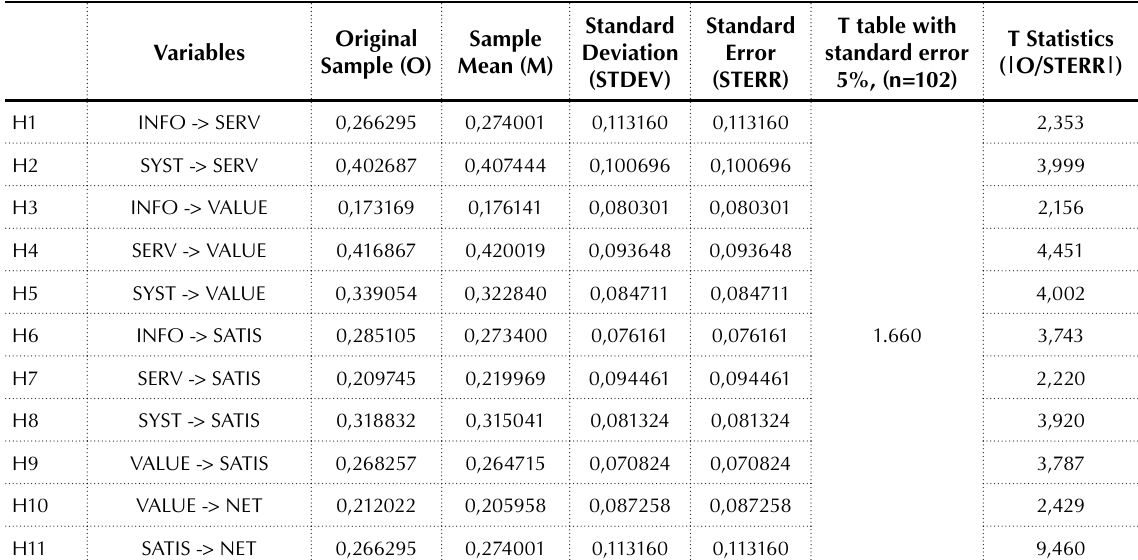
Table 4. Hypotheses testing results